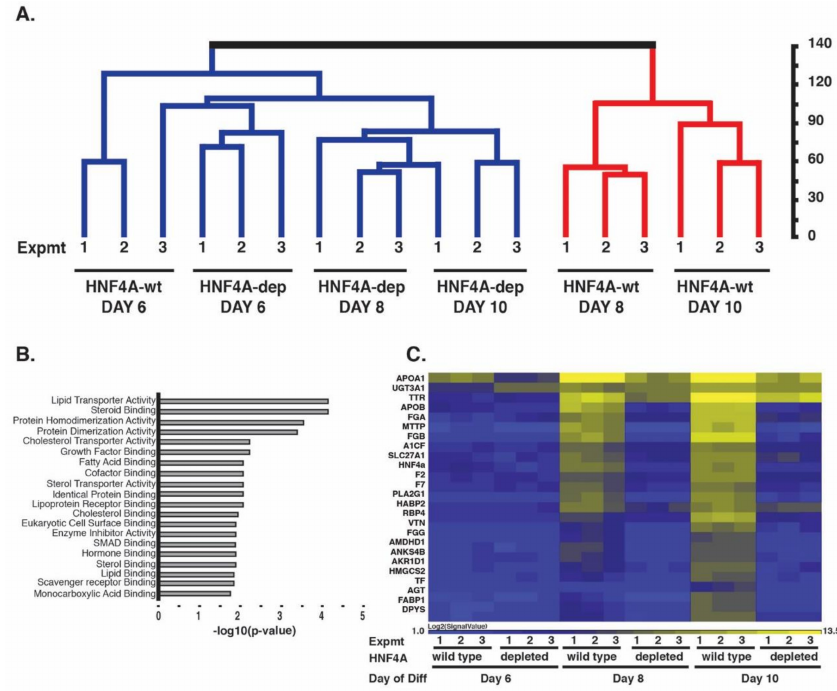
Figure 3. HNF4A is necessary for the transition of endoderm to hepatic fate during iPSC differentiation. ( A ) Dendrogram showing unsupervised hierarchical cluster analyses of transcriptional profiles generated using oligonucleotide arrays that were performed on triplicate differentiations of control and HNF4A-depleted cells collected immediately after addition of BMP4/FGF2 on day six (endoderm), day eight (early hepatic progenitor cells) and day ten (hepatic progenitor cells); ( B ) Gene ontology analyses of genes whose expression was reduced in the absence of HNF4A at day eight of differentiation; ( C ) Heat map showing the changes in levels of characteristic hepatic mRNAs at days six, eight, and ten of differentiation of control iPSCs (wild-type) and HNF4A-depleted (depleted) iPSCs. Scale = log2 of signal